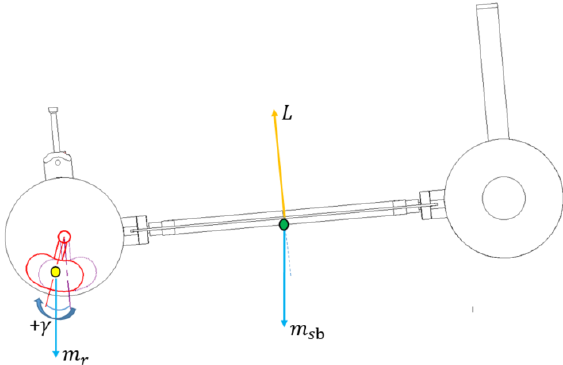
Figure 3. Schematic diagram of roller rotation.